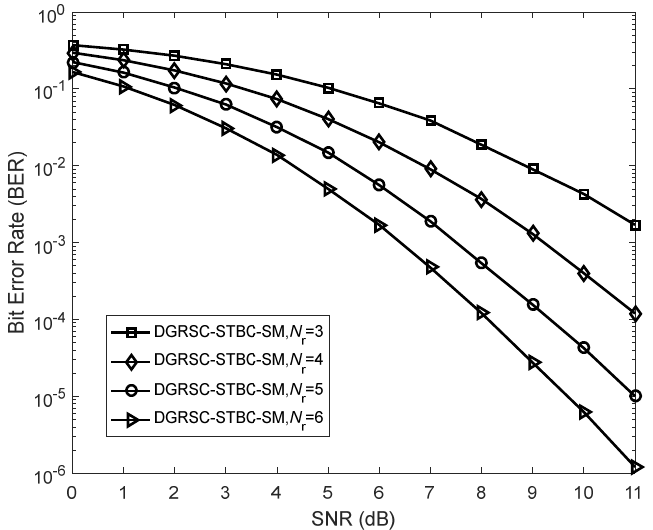
Figure 12. Error performance for DGRSC − STBC − SM scheme utilizing C with different numbers of receive antennas under Algorithm 1 , N